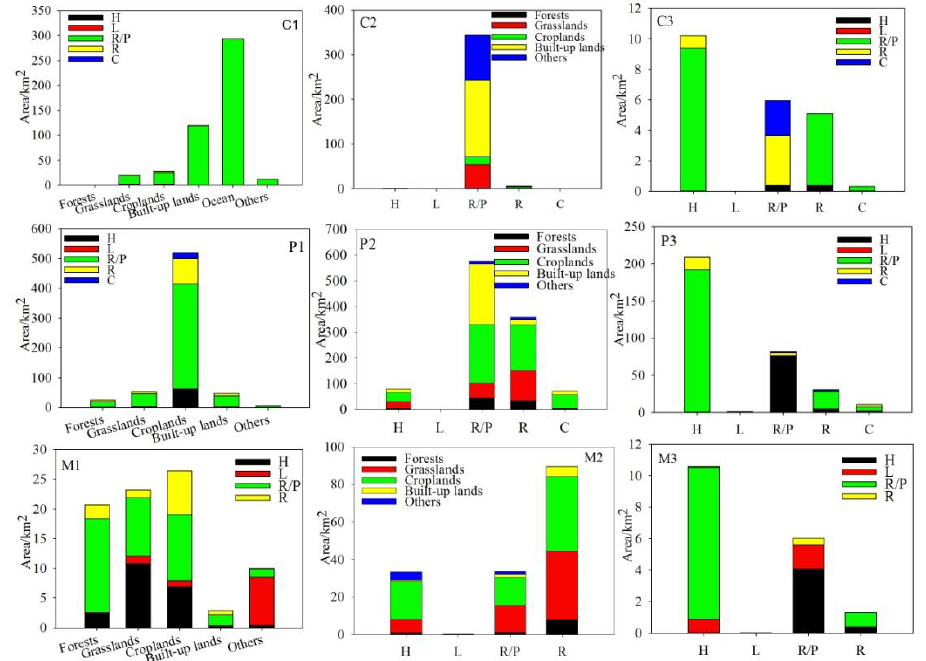
Figure 4. Modes of spatial wetland transformation. Note: C = coastal areas; P = plains; M = mountainous areas; 1 = wetlands-in (other land-use types converted into wetlands); 2 = wetlands-out (wetlands converted into other land-use types); and 3 = wetlands-internal (conversion between wetlands).